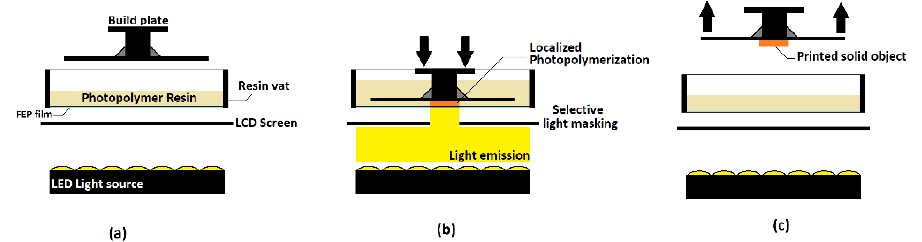
Figure 8. LCD VPP 3D printing schematic. ( a ) Overall configuration, ( b ) layer solidification step, ( c ) solid layer change step.